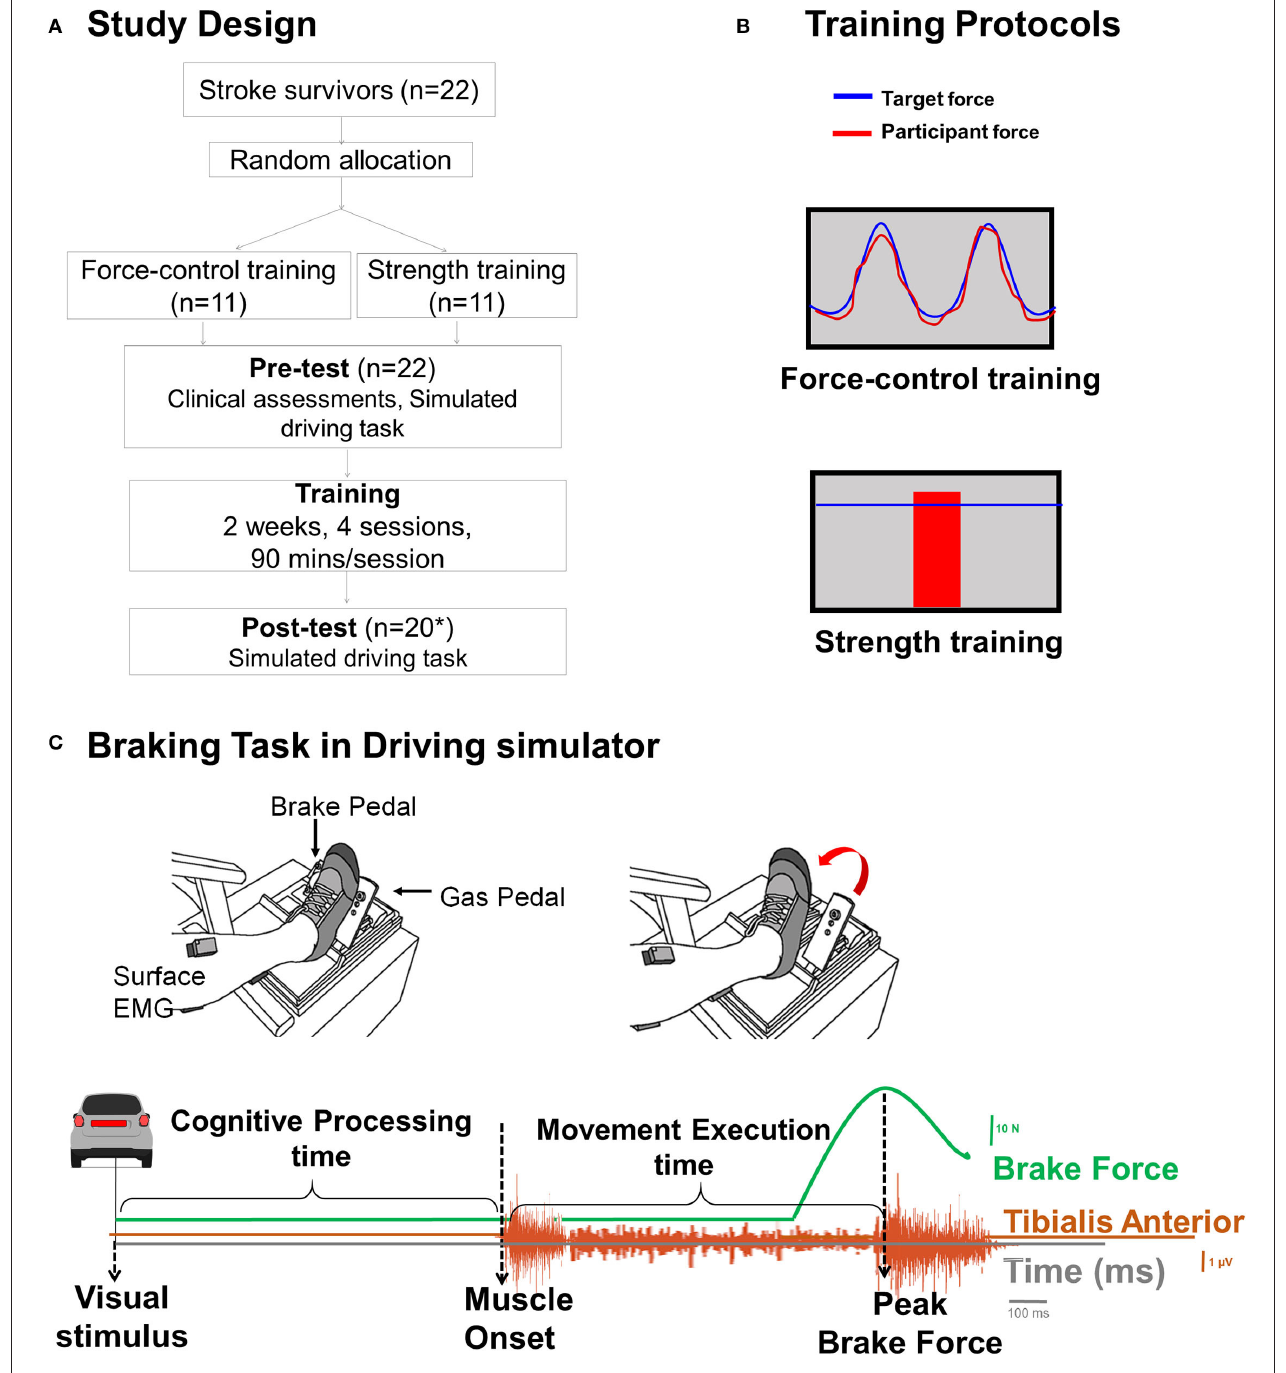
FIGURE 1 | (A) Study design. We randomly allocated 22 individuals with stroke to force-control or strength training. * One individual in each training group was lost to follow-up due to inability to return for post-test driving assessment. (B) Training description: The force-control training group performed a visuomotor force tracking task that involved matching participant’s ankle force to a sinusoidal force trajectory (top). Blue sinusoidal line represented the target trajectory with amplitude of 10% maximum voluntary contraction force (MVC) (range 5–25% MVC) and the red line shows the participant’s performance. The difficulty of force-control training progressed by decreasing the target frequency from 0.2, 0.1, 0.05, to 0.1Hz + 0.2Hz over 4 sessions. The strength training group performed rapid muscle contractions to reach a target force (bottom). The target force was displayed with blue horizontal line that represented a pre-determined percentage of their MVC force and participant’s performance was displayed with a vertical red bar. The difficulty of the strength training was progressed by increasing the target force from 65, 70, 75 to 80% of MVC force over 4 sessions. Both the groups performed the trainings with the driving leg in both contraction types (dorsiflexion and plantarflexion). (C) Time series of a single representative trial of braking task. The cognitive processing time was measured as the time between onset of the visual stimulus (brake lights of the lead car) and activation of tibialis anterior muscle. The movement execution time was measured as the time between the activation of tibialis anterior muscle activation to the peak brake